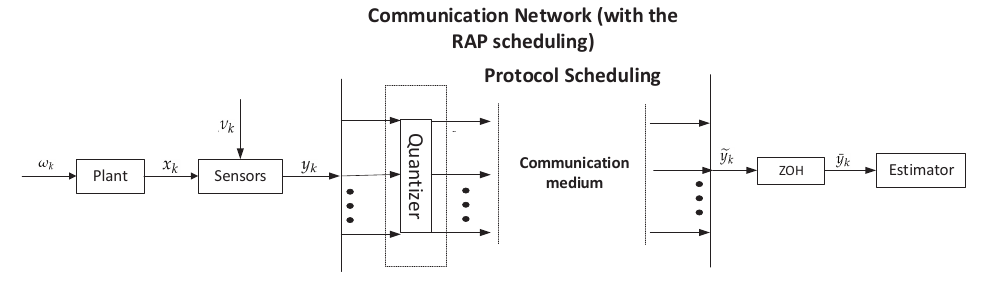
Figure 1. The structure block diagram of the RAP-based filtering